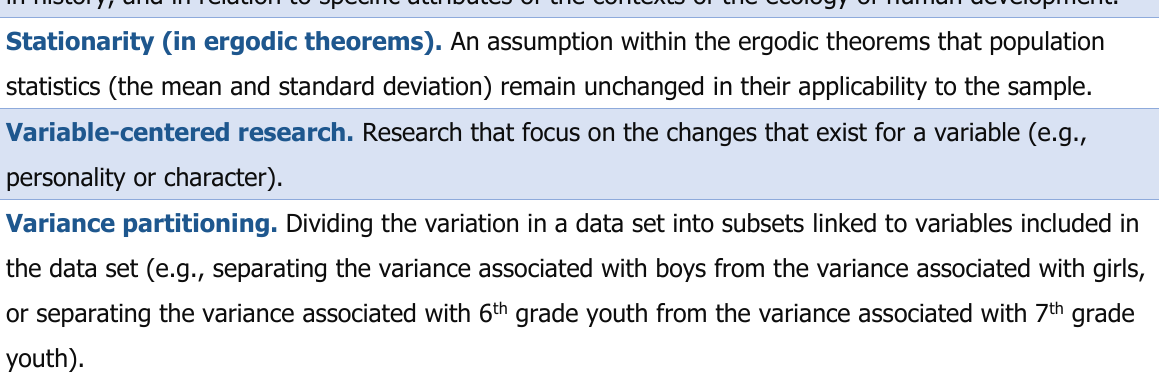
Table 2. Concepts Associated With Change-Sensitive Developmental Methods